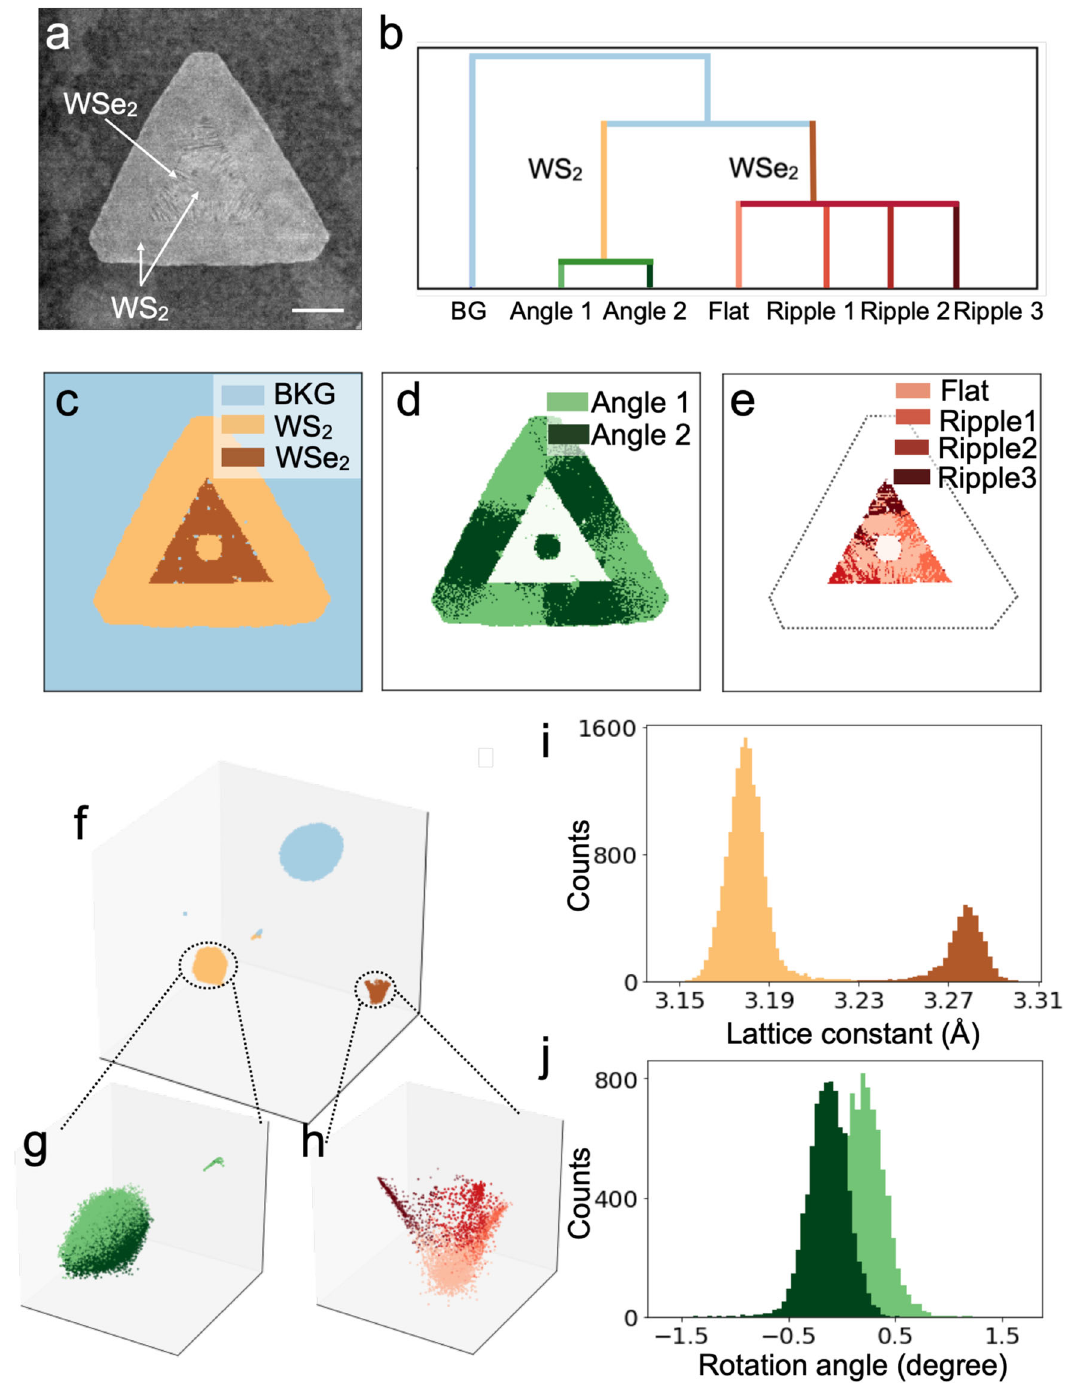
Fig. 2 Clustering results on WS 2 – WSe 2 lateral heterojunction. a ADF-STEM image of the WS 2 – WSe 2 junction. Scale bar, 500 nm. b Dendrogram of the unsupervised learning work fl ow. c – e Real space maps from the unsupervised learning results showing different compositions and deformations in the sample. f – h 3D manifold structure displaying the data distribution in each round of the clustering. i Histogram of measured lattice constants of WS 2 and WSe 2 color-coded with results in the second-round clustering. j Histogram of measured rotation angles of WS 2 color-coded with results in the third-round clustering of WS 2